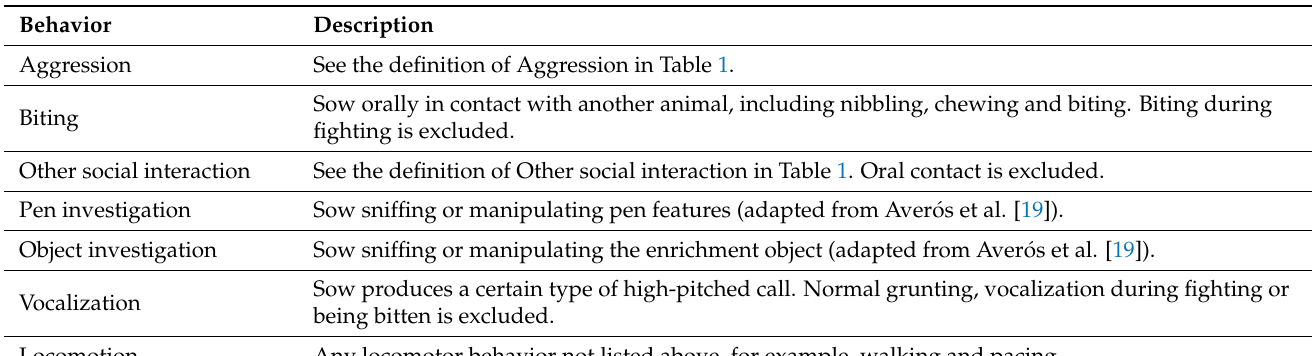
Table 2. Behavior categories for post-weaning